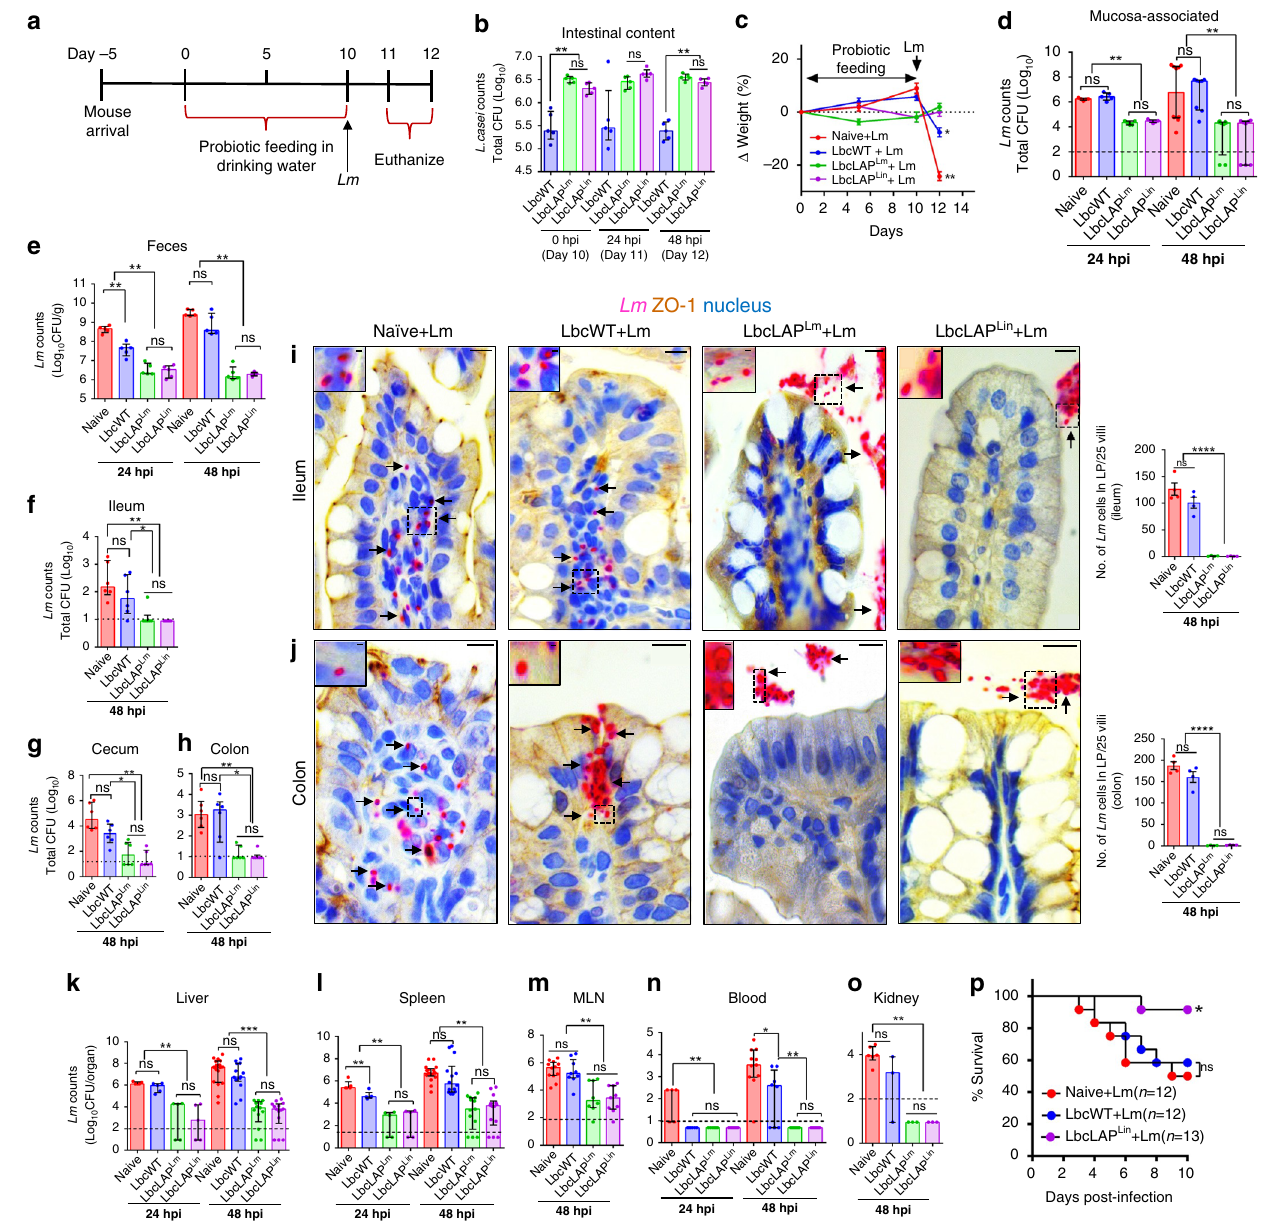
Fig. 2 BLP prevents lethal L. monocytogenes infection in mice. a Schematics showing mouse experiment protocol. b Increased BLP counts in the intestinal content of mice ( n = 5) on days 10, 11, and 12. c Normalized mouse body weight (mean± SD, n = 5) on days 0, 5, 10, and 12. d – h Reduced Lm burdens in the intestine ( d , mucosa-associated, n = 5 at 24 hpi; and n = 10, 8, 8, 8, at 48 hpi for each group, respectively), shed in the feces ( e , n = 5) and intracellular location in the ileum ( f , n = 6), cecum ( g , n = 6), and colon ( h , n = 6). i , j Micrographs of ileal ( i ) and colonic villi ( j ) immunostained for ZO-1 (brown) and Lm (red, arrows) and counterstained for the nucleus (blue) at 48 hpi. Bars, 10 µ m. The boxed areas were enlarged. Bars, 1 µ m. Lm counts (mean ± SEM) in ileal or colonic lamina propria (LP; right panels). Dots represent an average of 25 villi from a single mouse, four mice/group, n = 100 villi. Lm is observed in the LP (arrows) in naive or LbcWT-treated mice, but con fi ned in the lumen (arrows) in BLP-treated mice. k – o Reduced Lm burdens in the liver ( k ), spleen ( l ), ( k and l , n = 5 at 24 hpi; and n = 17, 14, 13, 14, at 48 hpi), MLN ( m , n = 11, 9, 8, 9, for each group, respectively), blood ( n , n = 5 at 24 hpi; and n = 11, 8, 8, 8, at 48 hpi for each group, respectively) and kidney ( o , n = 6, 3, 3, 3, for each group, respectively). p Increased survival of BLP-treated mice at LD 50 dose. * P < 0.05 Kaplan – Meier log-rank test. For plots b , d – h , and k – o each point represents an individual mouse ( n ) from three to six independent experiments (median and interquartile range). Dashed horizontal lines indicate the limit of detection for each organ/tissue. Mann – Whitney nonparametric (two-tailed) test ( b , d – h , k – o ) was used and comparisons were made between each treatment group individually or by using the one-way ( c , i , and j ) ANOVA test followed by a Tukey ’ s multiple comparisons. For all analyses, **** P < 0.0001; *** P < 0.001; ** P < 0.01; * P < 0.05; ns no signi fi cance. Source data are provided as a Source Data fi